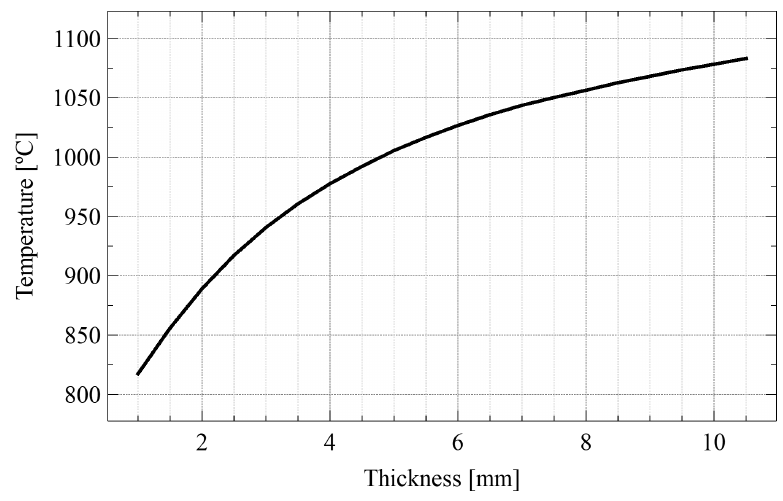
Figure 10. Window average temperature for different window thickness values.